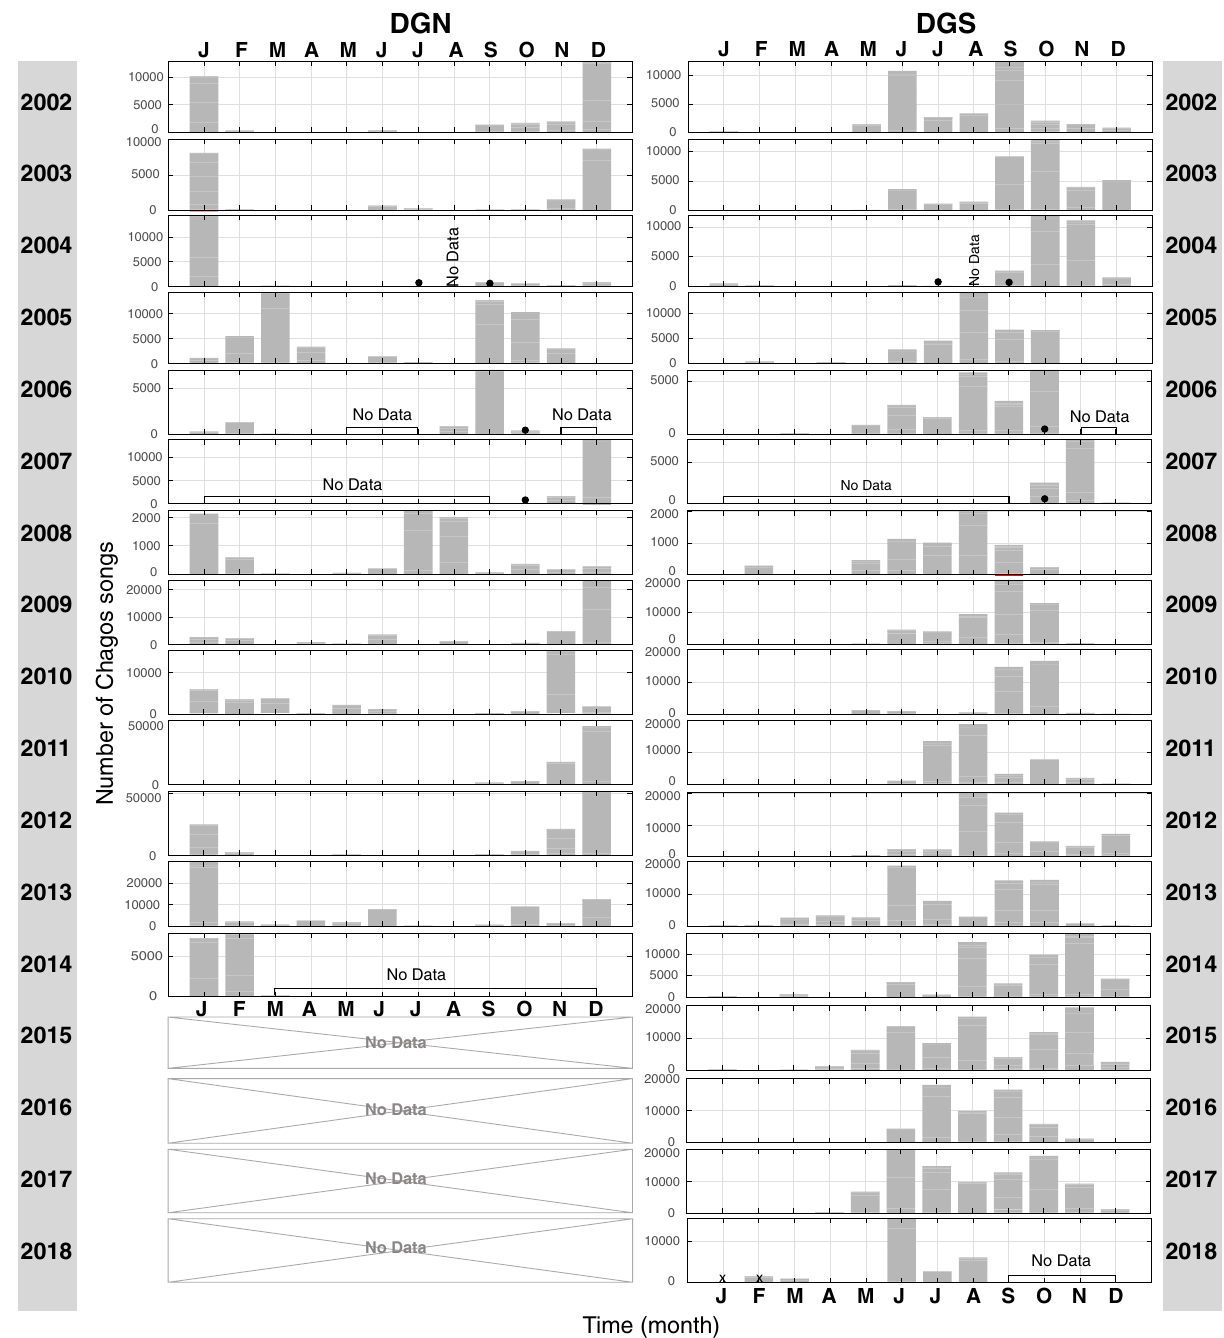
Figure 10. Number of Chagos songs per month for each year at DGN and DGS. Note that the scale of the y-axis differs among years to highlight the seasonal patterns. Months without data are indicated by ‘No Data’, and months with more than 50% of missing days are indicated by a black